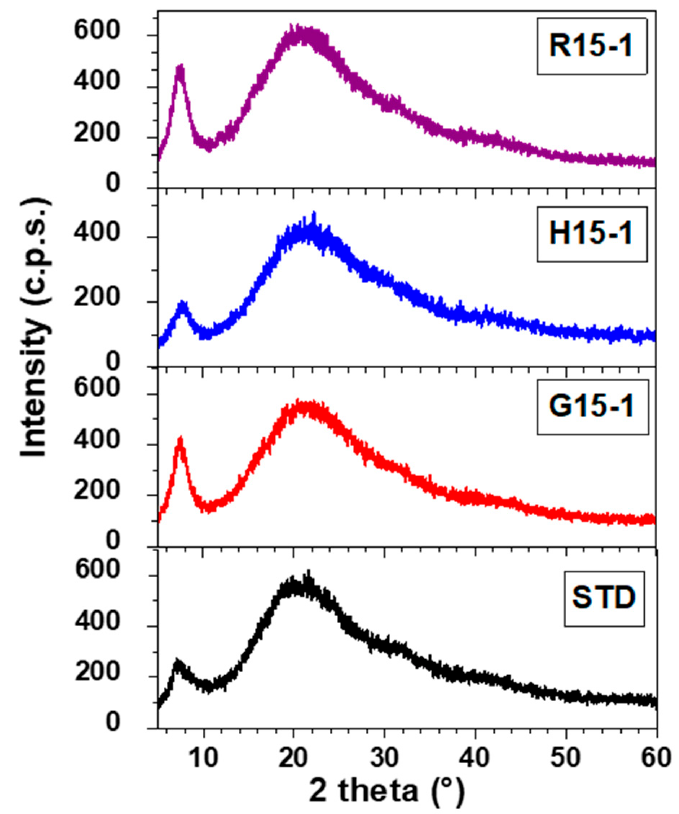
Figure 7. X-ray diffraction diagram of skin collagen from Oreochromis niloticus . R15-1: red tilapia 15-months old, H15-1: F1 (XY from red YY x gray XX) 15-months old, G15-1: gray tilapia 15-months old and STD: collagen skin calf type I (SIGMA). Table 4. X-ray diffraction pattern estimates of tilapia skin collagen samples at 9, 15, 24, and 36 months.